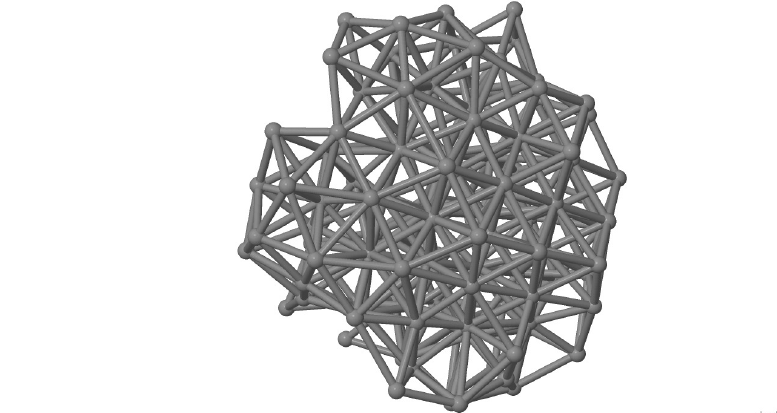
Figure 1: A sample of a simulation result for the unoriented two-body interac- tion showing signs of fcc structure. The figure was created by using the Jmol soft- ware [ 45 ] . An interactive 3D version of the figure can be viewed with Adobe